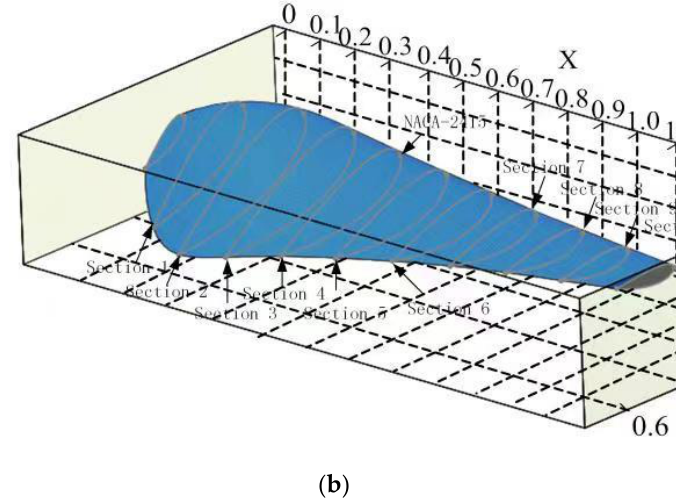
Figure 4. ( a ) Distribution of chord length and twist angle of blade ( b ) Three-dimensional model.